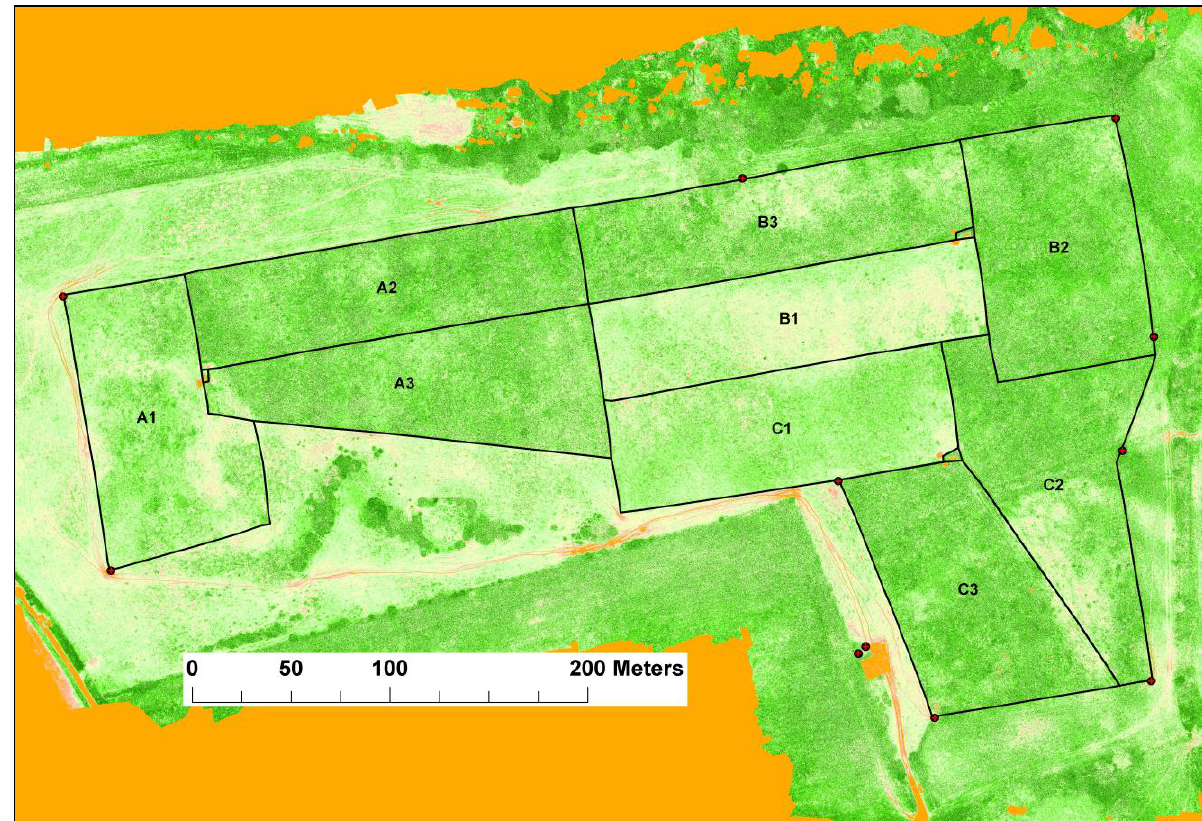
Figure 3 . RGBVI analysis of the UAV-derived orthophoto in original spatial resolution of 0.013 m (05 June 2020).